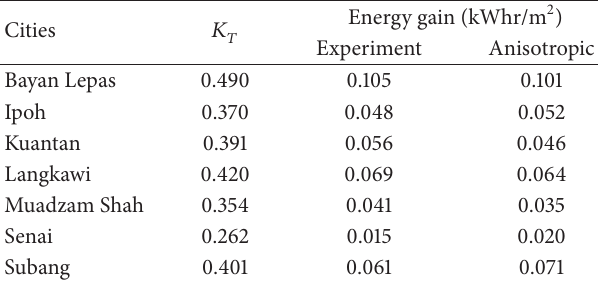
Table 4: Energy gain based on experimental curve and isotropic model on evening segment.